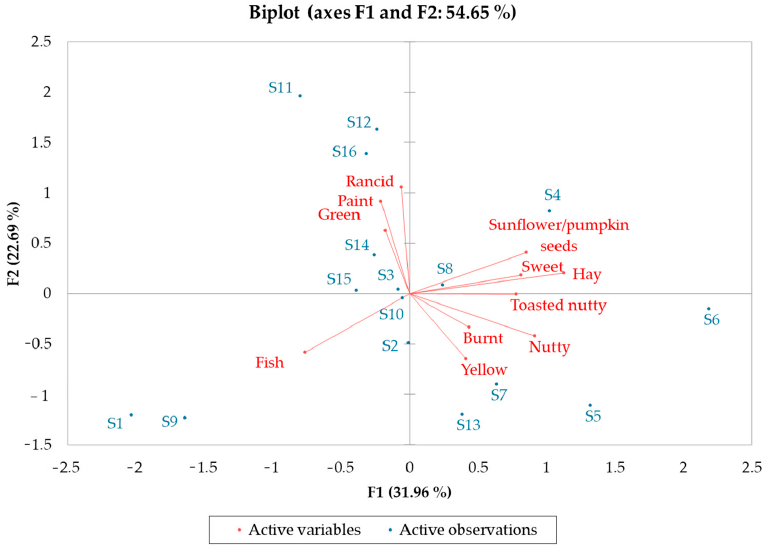
Figure 5. Principal component analysis plot of the intensities of sensory descriptors and samples of CP-HSO.